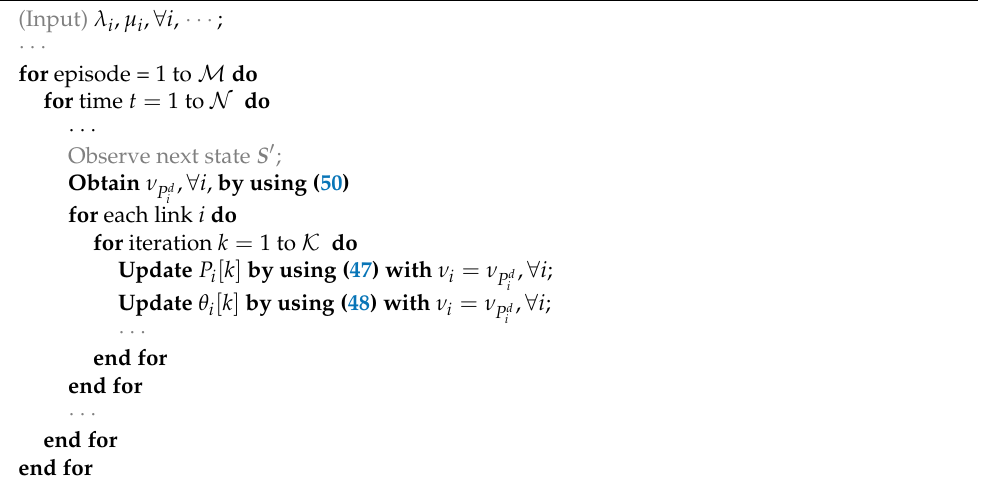
Algorithm 4 The two-layer hybrid MRA training algorithm with the pricing